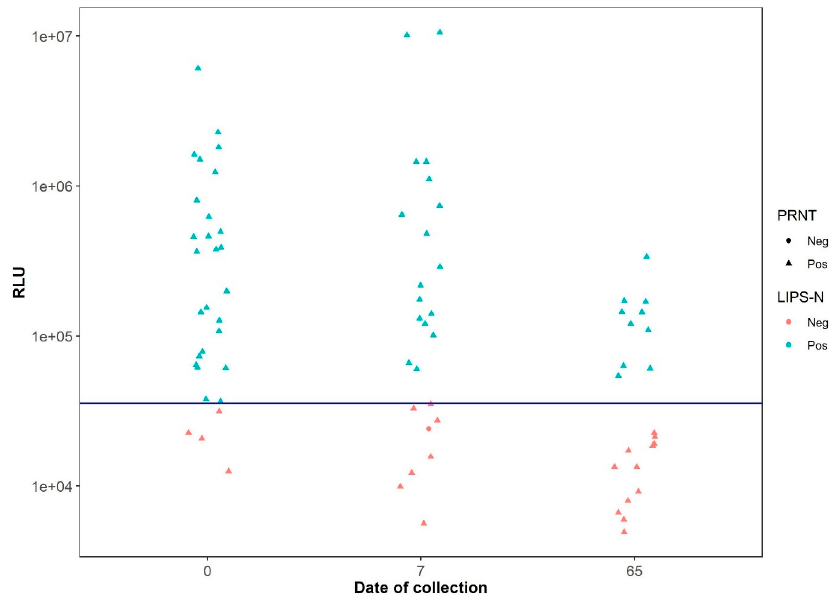
Figure 5. Distribution of RLU values generated using the sera from naturally SARS-CoV-2-infected mink samples across the threshold line for the LIPS-N assay according to the serum collection date. Note that the RLU values generated from NT positive sera declined over time using LIPS-N and an increased number of NT positive sera fall below the threshold line.